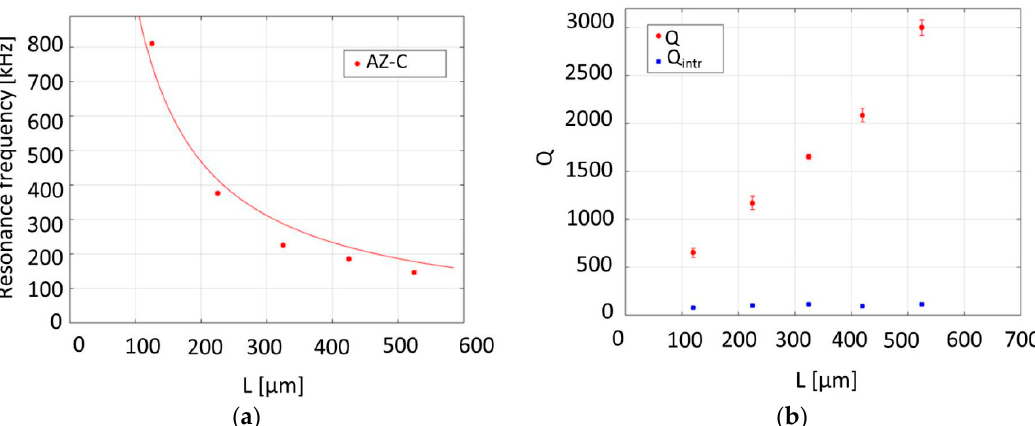
Figure 5. Relation between length, ( a ) resonance frequency (fit to Equation (2) included) and ( b ) Qs of the carbon strings fabricated with “ dry etch-pyrolysis ” strategy ( red ) and calculated values for resonators without tensile stress ( blue ). Error bars represent a 95% confidence interval.